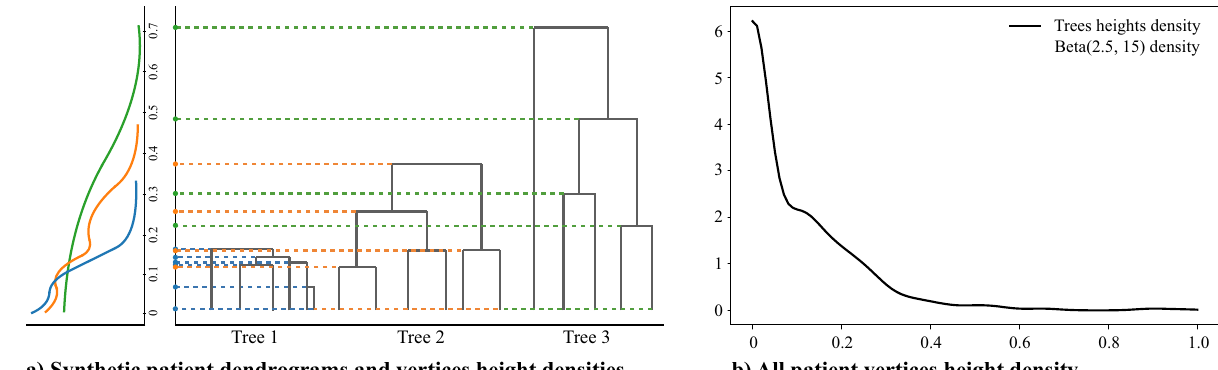
Figure 7. Choice of µ : ( a ) costruction of qualitative densities of the vertices heights in three example dendrograms: the velocity with which leaves get merged in a dendrogram, i.e., edges length variability, reflects the heterogeneity characterization of lesions. Per every dendrogram, branches heights (rescaled on [0, 1] dividing by the highest value) are annoted on the left and their associated density is inspected. The vertices heights of a patient exhibiting homogeneous lesions concentrates in a small real interval [0, a ]—with a > 0 (blue tree); the vertices heights of a patient exhibiting heterogeneous lesions spread in a range of values far from zero [ a , b ], with a , b > 0 (green tree); a patient showing groups of homogeneous lesions, the one heterogeneous to the others, is associated to a dendrogram with an explicit clustering structure with clusters with multiple close leaves (orange tree). The vertices heights distribution displays two components, reflecting both the homogeneity of similar lesions—with values close to 0—and the heterogeneity of dissimilar clusters—with values far from 0; b) µ provides the coefficients with which to weight the different pruning cutoffs ε , to neglect the homogeneity within clusters of similar lesions’ phenotypes and bring out the informative heterogeneity between different phenotypes. To efficient the computation, a parametric shape of µ is used and empirical heights distributions of all patients (black line) is exploited to model the distribution. In the population heights distribution, we discern both homogeneous and heterogeneous phenotypes. The two components are demarked with a saddle point on 0.15. Accordingly, low weights of µ should be associated to ε ≪ 0.15 and ε ≫ 0.15 and high weights to ε ≃ 0.15 . In fact, low ε values entail pure homogeneity information while high ε values would lead to discarding useful heterogeneity information. We thus infer to model µ as an asymmetric bell-shaped density function with one peak centered in the saddle point of the heights distribution. The Beta family of distributions, supported in [0, 1], well meets the requirements; it simplifies both the numeric integration procedure and the results’ interpretation. The Beta-shaped µ is centered on 0.15 (grey line), properly tuning α and β shape parameters ( α = 2.5, β = 15